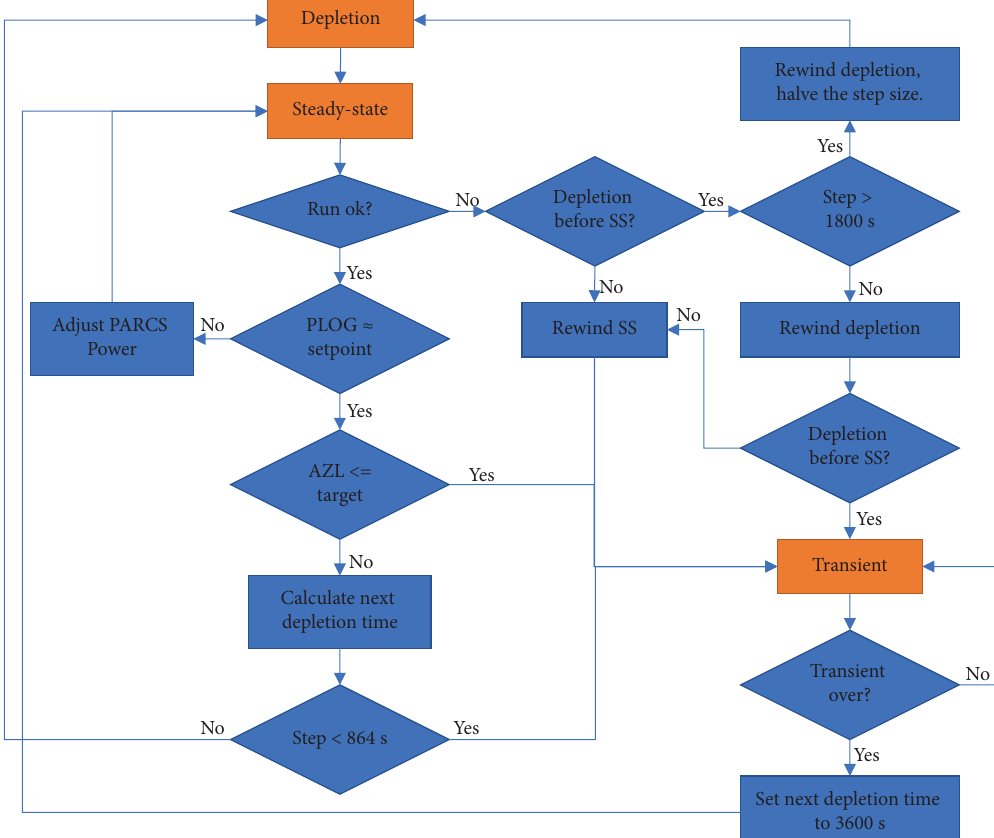
Figure 3: Hybrid methodology for performing a shim